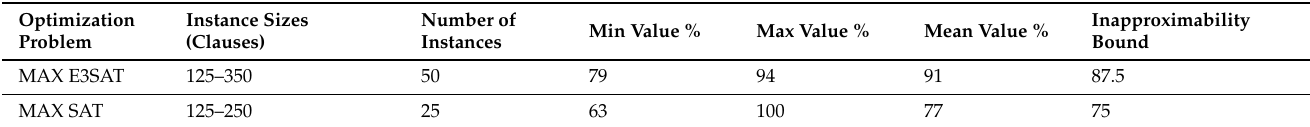
Table 1. Results from numerical tests . Note that OPT may be less than 100 since some instances were unsatisfiable with high